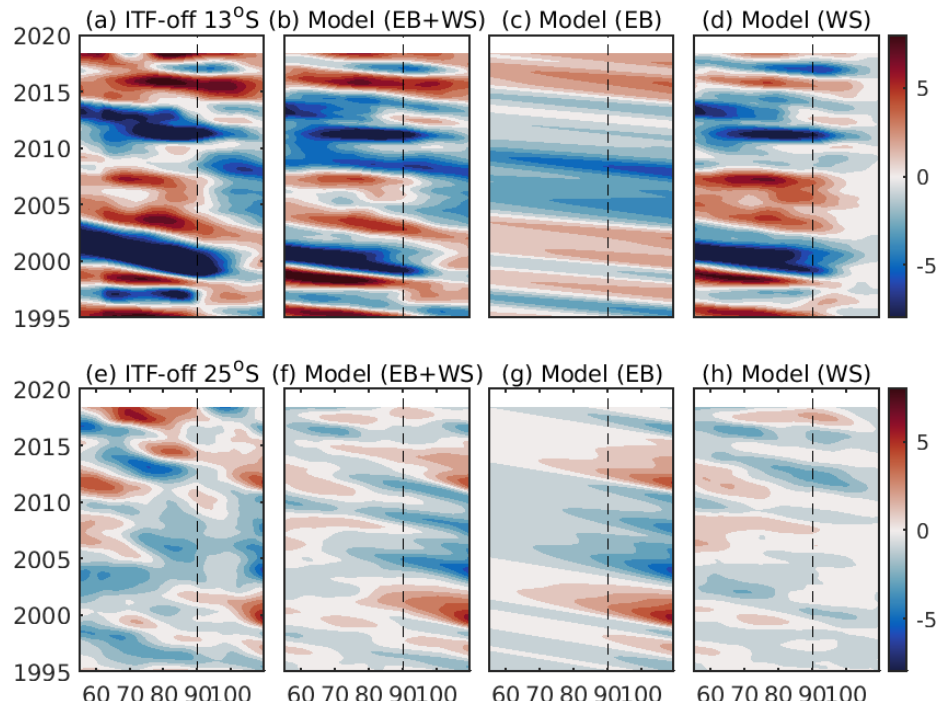
Figure 10. Hovmöller diagrams of (a, e) the ECCO-modeled SLA at 13 and 25 ◦ S from the ITF-off simulation, (b, f) the RG-modeled SLA using both the eastern boundary and the local wind stress curl forcing, (c, g) the RG-modeled SLA obtained using the eastern boundary forcing only, and (d, h) the RG-modeled SLA obtained using the local wind stress curl forcing only. The results from the ITF-off simulation at 13 ◦ S are shown in the top panels, and those at 25 ◦ S are shown in the bottom panels.